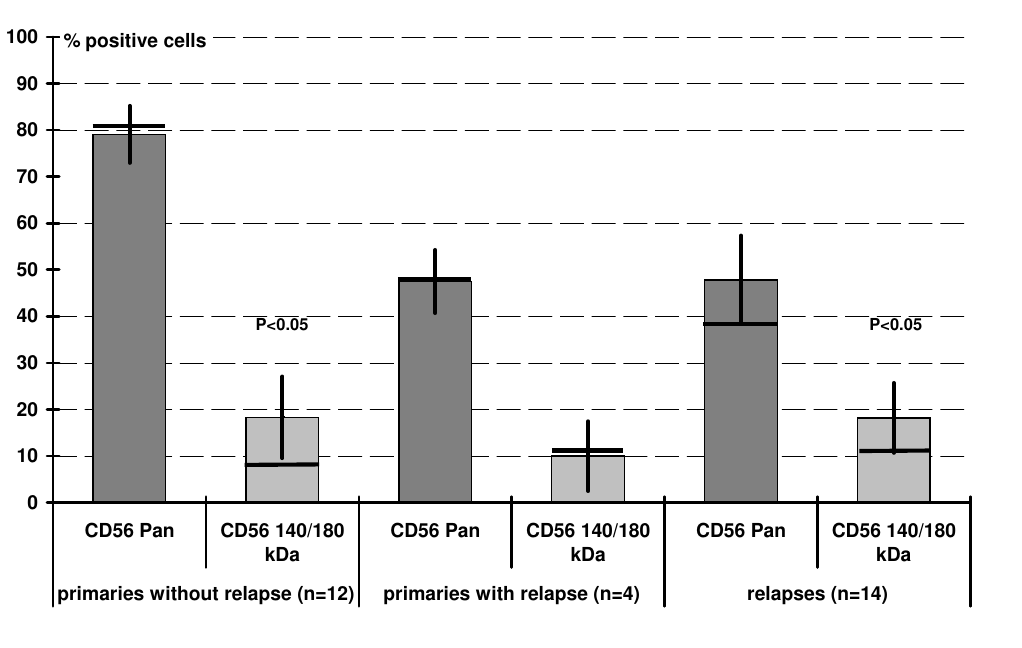
Percentage of positive stained tumor cells (average with standard error, bar: median)